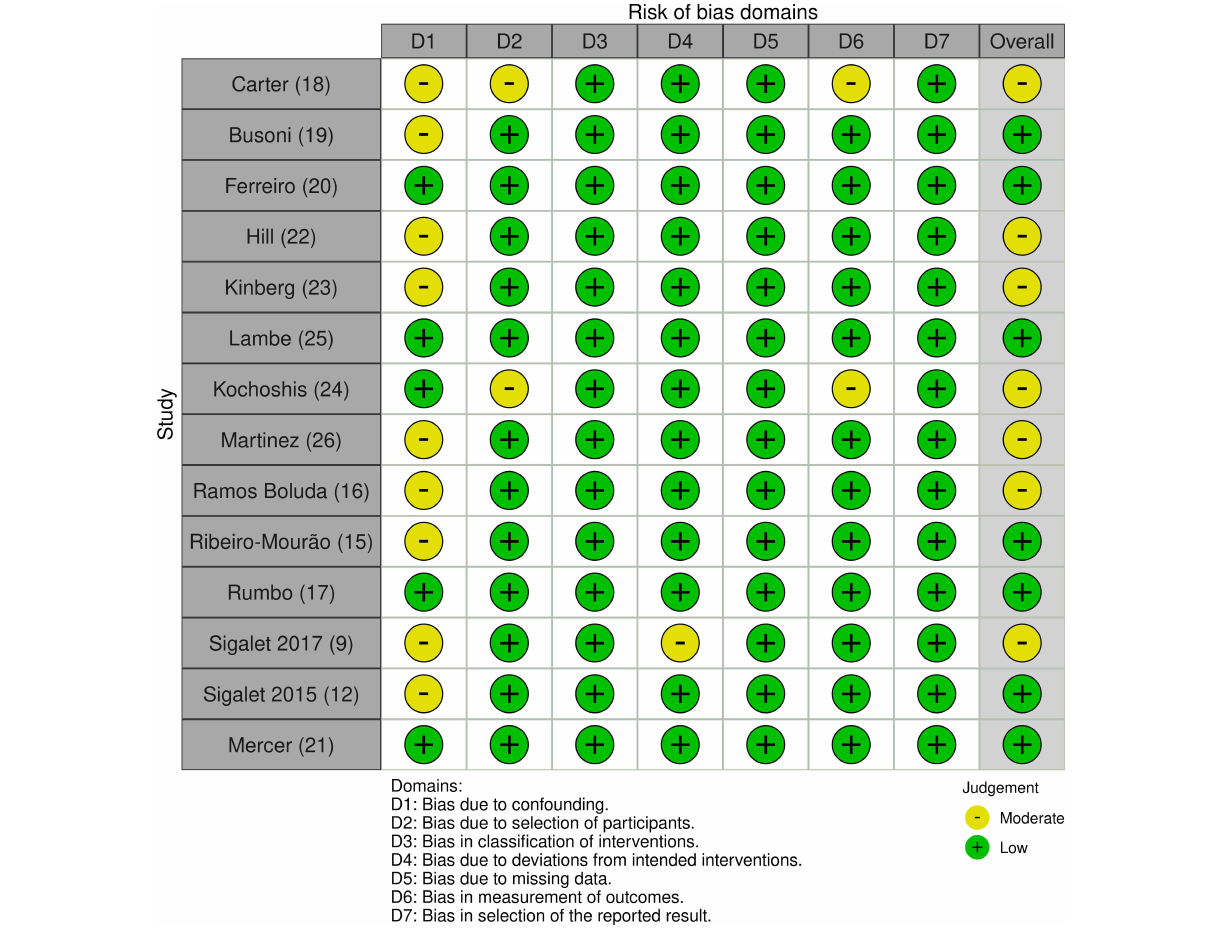
FIGURE 2 | Quality assessment results according to